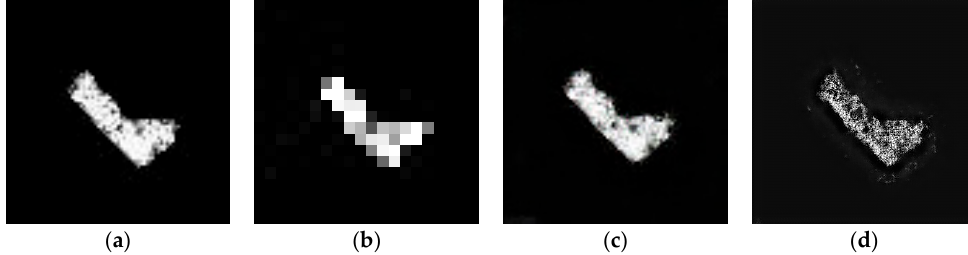
Figure 10. SAR image enhancement based on SRGAN: ( a ) image after segmentation (78 × 78), ( b ) image after quadruplet sampling (19 × 19), ( c ) the reconstructed image (78 × 78), and ( d ) the enhanced image (312 × 312).